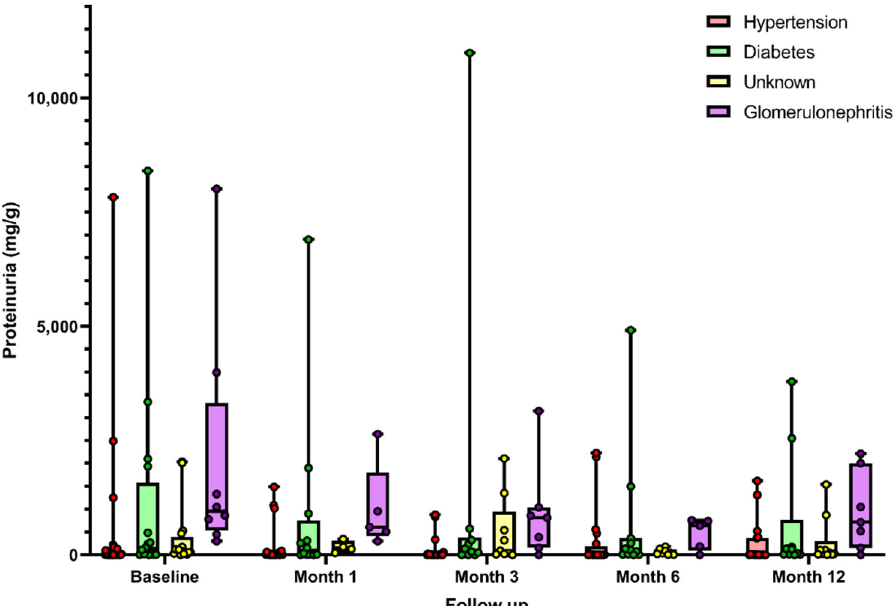
Figure 3. Descriptive plot of UPCR evolution according to the different etiologies of CKD. Values are expressed as mean and min/max range. Etiology was hypertension in 32 patients, diabetes in 16, unknown in 15 and glomerulonephritis in 7. No statistical significance for the trend was observed in subanalysis of each subgroup during follow-up (linear regression models). No adverse events were reported during the